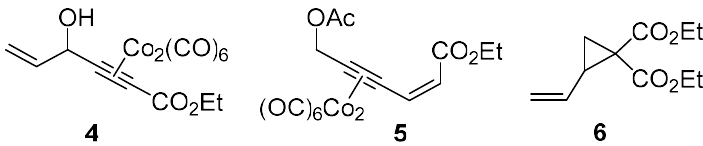
Figure 2. Existing ε-carbonyl cation equivalent precursors.